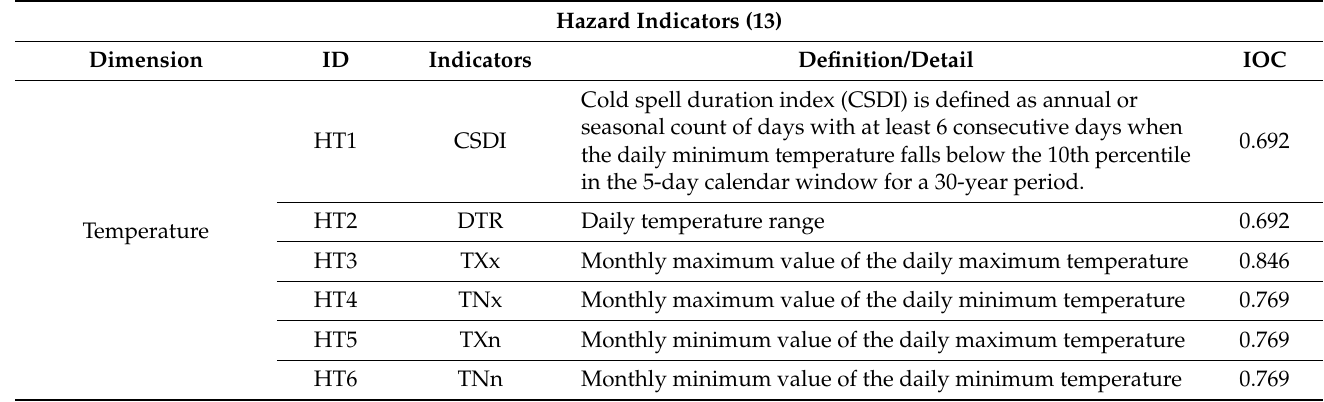
Table 1. The UHI hazard indicators, definitions and expert-validated IOC indexes. Hazard Indicators